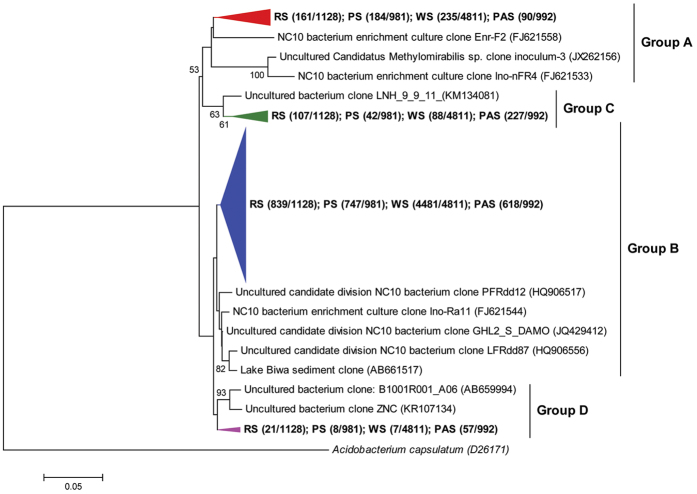
Neighbour-joining phylogenetic tree showing the phylogenetic affiliations of the 16S rRNA gene sequences of NC10 phylum bacteria recovered from the examined freshwater habitats.Bootstrap values were 1,000 replicates, and the scale bar represents 5% sequence divergence. Bootstrap values >50 (500 replicates) are shown at the branches.